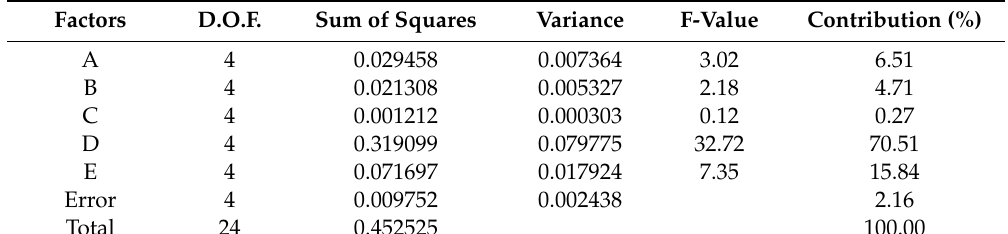
Figure 18. The effect of each factor on the performance of the two responses. Table 14. ANOVA table for the grey relational grade. Table 14. ANOVA table for the grey relational grade.